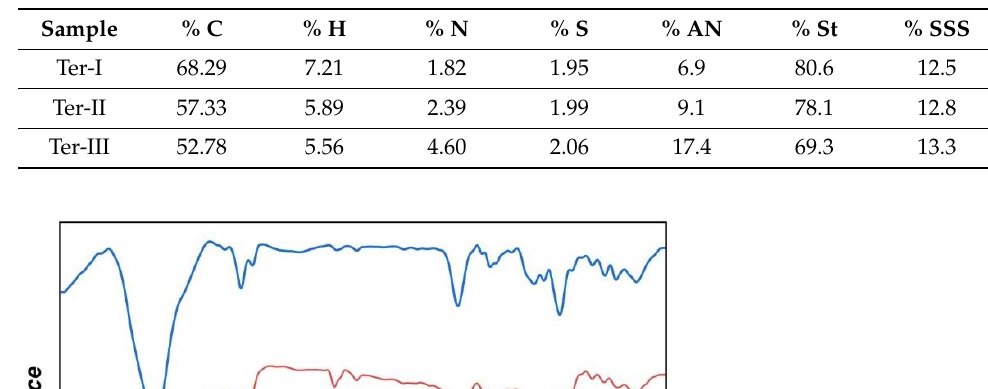
Table 2. The elemental analyses and the calculated monomer ratios of the terpolymer species.